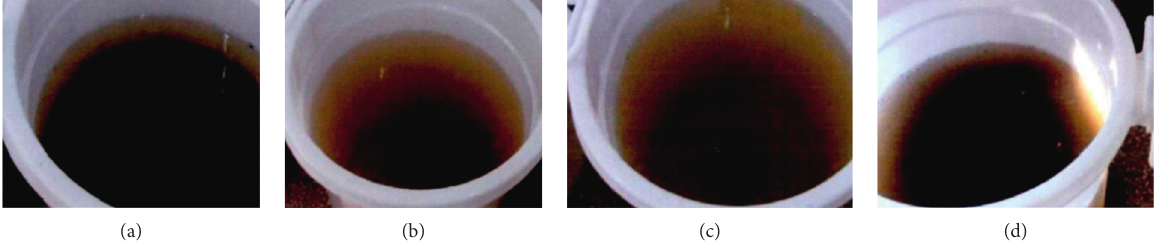
Figure 7: Intuitive chart of changes in water quality of each group (https://image.baidu.com/). (a) Microorganisms+plants. (b) Mi- croorganisms. (c) Plants. (d) Control